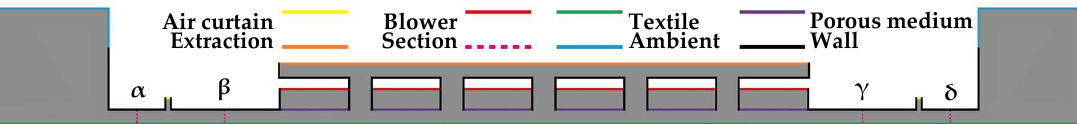
Table 4. Main boundary conditions assigned for preliminary CFD analyses.